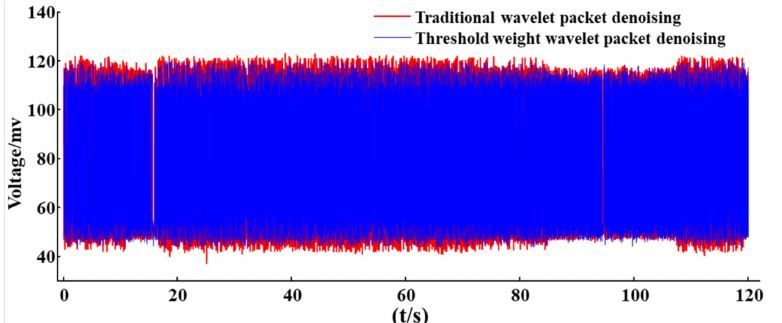
Figure 11. Comparison of the denoising effect between the traditional wavelet packet and threshold weight wavelet